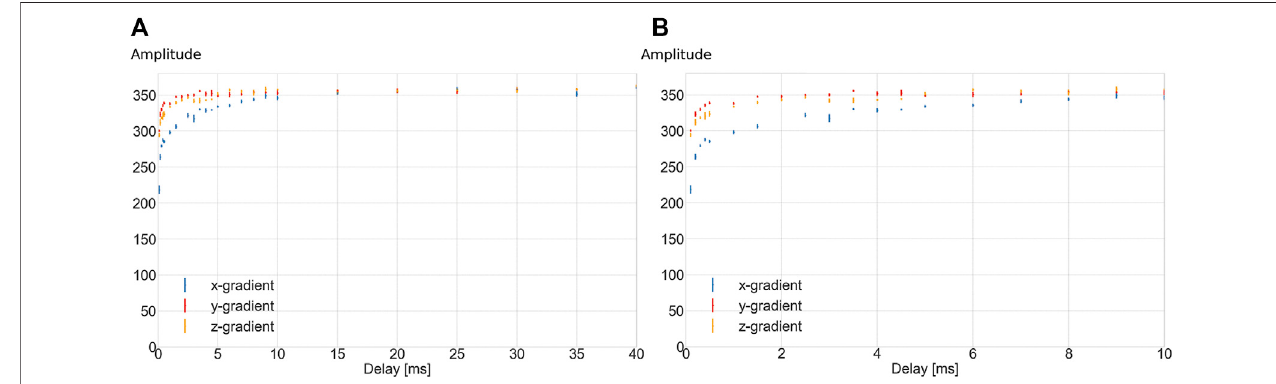
FIGURE11| Signalamplitudes(arbitraryunits)ofthemagnitudespectrumasafunctionofthedelaytimeafterthegradienthasbeenturnedoff,beforethespectrum isacquired.Full extent ofdelay times upto40 ms (A) , and zoomed viewofthe fi rst10 ms ofthedata (B) . Theaverage and standard deviation offourmeasurements per delay time are displayed. Blue: x -gradient, red: y -gradient, yellow: z